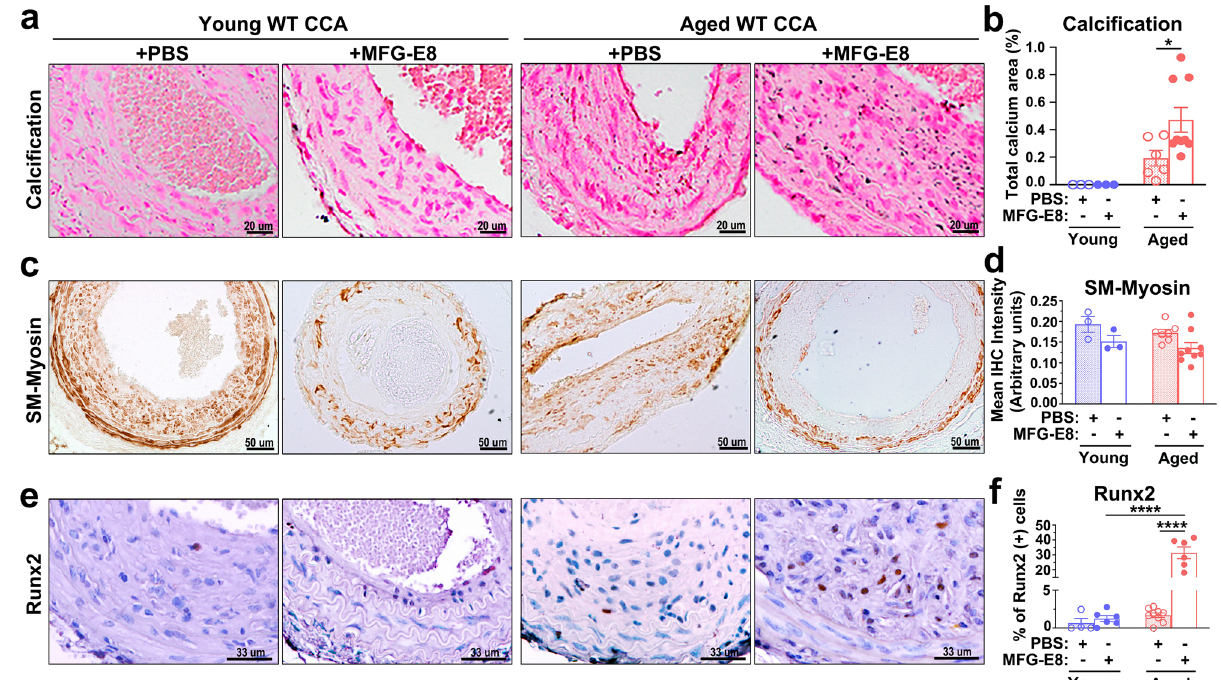
Fig. 3 Exogenous application of milk fat globule – epidermal growth factor 8 (MFG-E8) promotes the vascular calci fi cation and osteogenic transdifferentiation of vascular smooth muscle cells in aged mice. Common carotid arteries (CCAs) of young and aged wild-type (WT) mice were ligated to induce vascular remodeling. Pluronic gel containing phosphate-buffered saline (PBS) or rMFG-E8 was applied on CCAs immediately after the ligation. a , b Paraf fi n sections of ligated CCAs 21 days postligation were subjected to von Kossa staining. a Representative images of CCA sections from four groups of mice indicating calcium deposition in the arterial walls. b Quanti fi cation of calci fi ed area in the arterial walls (Young + PBS: n mice = 3, Young + MFG-E8: n = 3, Aged + PBS: n = 6, Aged + MFG-E8: n = 9). Results are presented as mean ± standard error of the mean (SEM). Each data point is derived from an assessment of three sections of one individual animal. * P < 0.05, as obtained using one-way analysis of variance (ANOVA) followed by Tukey ’ s multiple comparisons test. c Representative immunohistochemistry (IHC) images of smooth muscle myosin (SM-Myosin) in the CCAs of mice 21 days after ligation. Scale bar: 50 μ m. d Quantitative analysis of the immunostaining intensities of SM-Myosin in the intimal medial area was performed (Young + PBS: n mice = 3, Young + MFG-E8: n mice = 3, Aged + PBS: n mice = 7, and Aged + MFG-E8: n mice = 9). Data are presented as mean ± SEM. Each data point was derived from an assessment of three sections from one individual animal. e Representative IHC photomicrographs of runt-related transcription factor 2 (Runx2) in the ligated CCAs 21 days after surgery. Scale bar: 33 μ m. f Quantitative IHC analysis of the percentage of Runx2-positive cells over the total cell number in the intimal medial area (Young + PBS: n mice = 4, Young + MFG-E8: n mice = 6, Aged + PBS: n mice = 9, and Aged + MFG-E8: n mice = 6). Data are presented as mean ± SEM. Each data point was derived from an assessment of three sections from one individual animal. **** P < 0.0001, obtained using one-way ANOVA followed by Tukey ’ s multiple comparisons